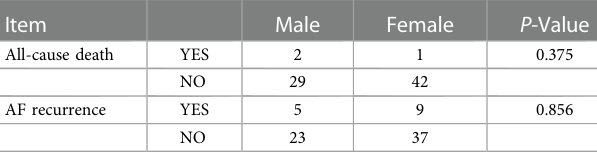
TABLE 5 Correlation between all-cause death, AF recurrence and gender of patients.